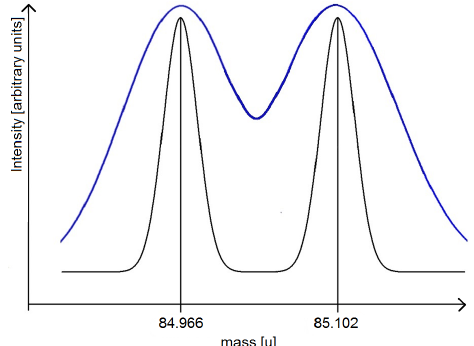
Figure 3. Schematic display of two different mass resolutions (blue and black curves). Two signals on masses 84.966 and 85.102u with equal intensities demonstrate the mass separation with R = 600 (blue curve) and R = 3700 (black curve). Assuming Gaussian peak shapes for the signals, R = 3700 separates both peak by 8 σ (quan- titative separation) and R = 600 separates them by only 2 σ (quali- tative